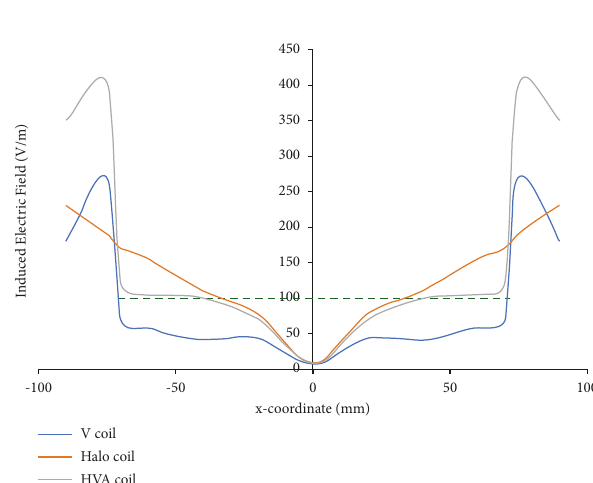
Figure 5: Electric field distribution along test line 1. Green dotted line indicates the neuron stimulation